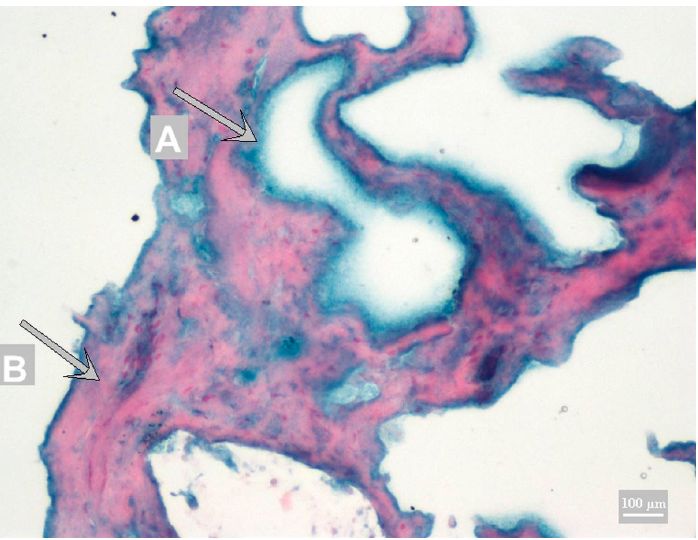
Figure 3. Fast Nuclei Red with HistoGreen chromogen; A chromogen precipitate—calcium caseinate (green); B muscle fiber (red).